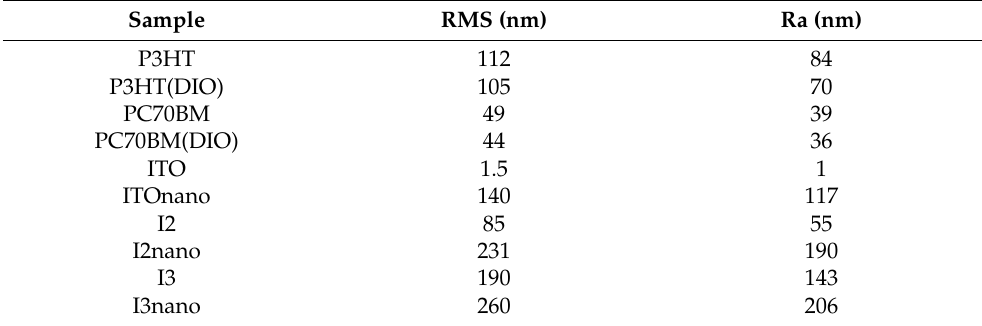
Table 4. Surface amplitude parameters (RMS and Ra) evaluated from the AFM